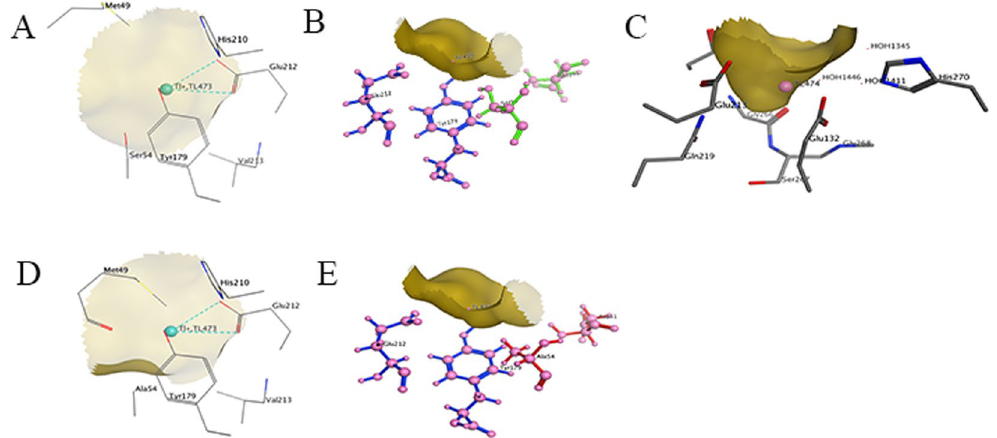
Figure 3. Ligand interaction analysis of the ammonium-binding site and Ser54. ( A ) and ( B ) The interaction surface of the negatively charged pocket formed by Ser 54, Asp 51, Glu 212 ′ , and Tyr 179 ′ with Tl + 473 ion. ( C ) The interaction of the negatively charged binding site of Tl + 474 with the amino acid residuals, Mn 2 + and H 2 O. ( D ) and ( E ) The Tl + 473 interaction surface and Met49 conformational change caused by